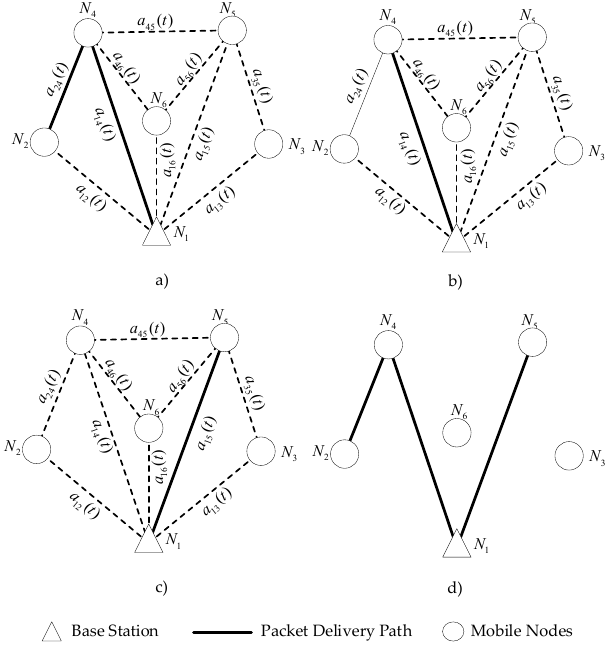
Mobile NodesPacket Delivery Path